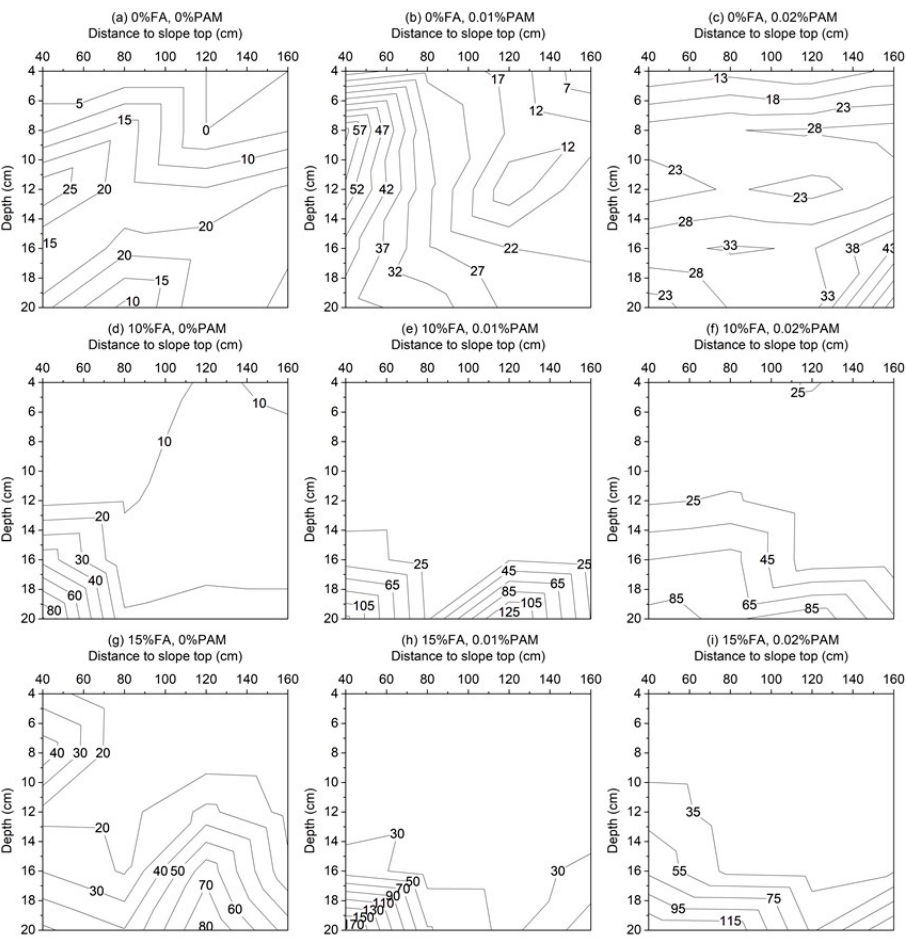
Figure 10. Contour plot displaying redistribution of NH 4+ -N (Unit: mg/kg) in soil profiles amended with different CFA and PAM dosages (i.e., 0% CFA + 0% PAM ( a ), 0% CFA + 0.01% PAM ( b ), 0% CFA + 0.02% PAM ( c ), 10% CFA + 0% PAM ( d ), 10% CFA + 0.01% PAM ( e ), 10% CFA + 0.02% PAM ( f ), 15% CFA + 0% PAM ( g ), 15% CFA + 0.01% PAM ( h ), 15% CFA + 0.02% PAM ( i )) after rainfall.